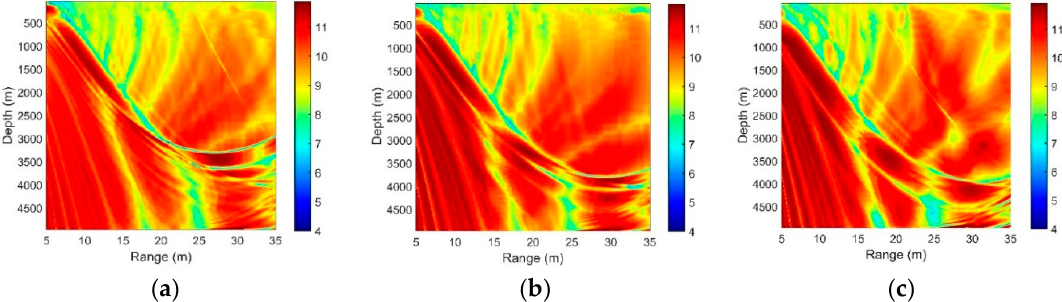
Figure 8. SG with different array locations for the center frequencies of ( a ) 150 Hz and ( b ) 450 Hz.